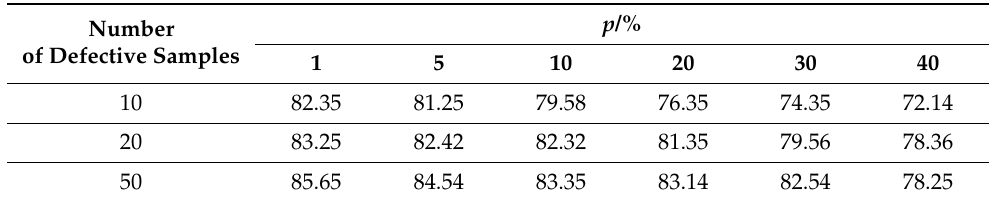
Table 4. Model recognition rates under different noise